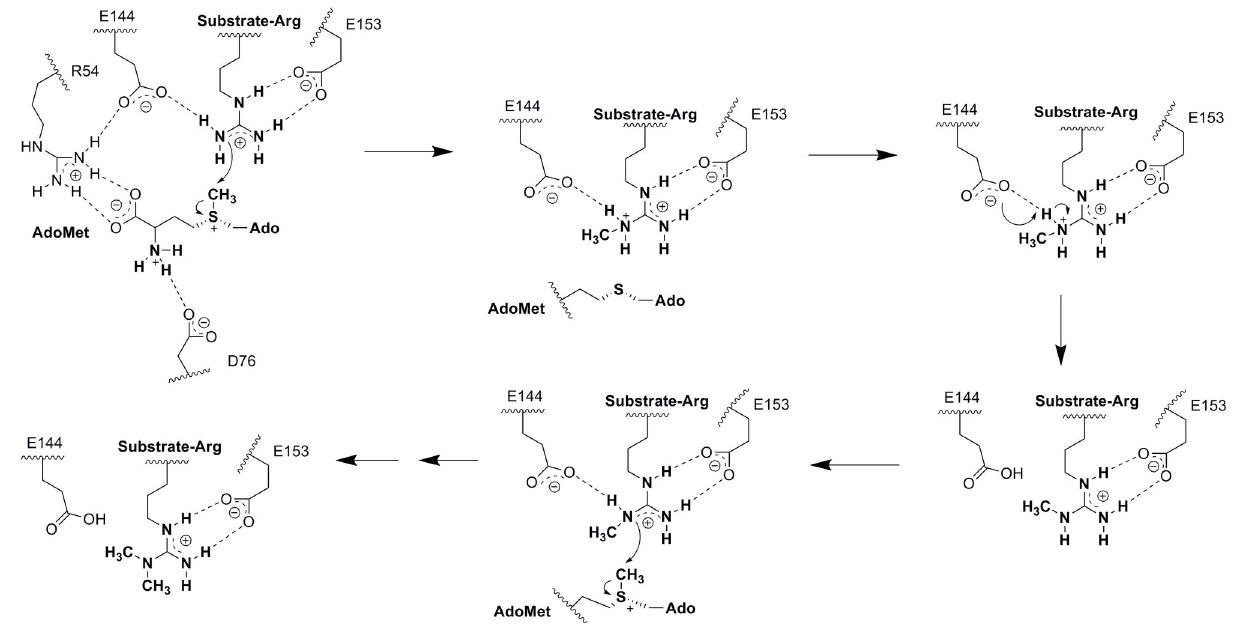
Figure 5. Proposed PRMT1 Catalytic Mechanism. doi: